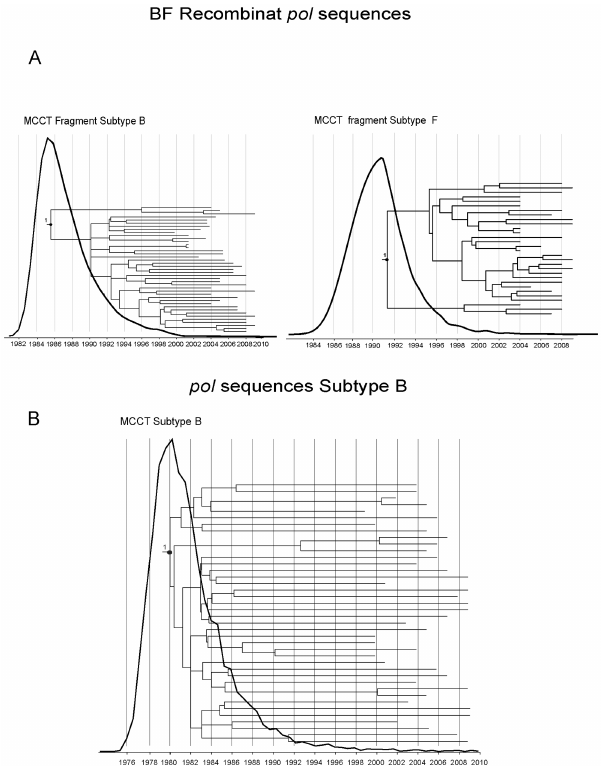
Fig 4. Bayesiananalysis for BF recombinant sequences and pure B sequences from MSM population. Time-calibrated maximum clade credibility trees (MCCT) of HIV-1 BF and B clades identified in the pol ML analyses.(A) For BF recombinant sequenceswe obtained two MCCT corresponding to the analysisof pure subtype B and F fragmentsindependently of each other. (B) MCCT obtainedby analyzingthe subtype B pure sequences. The posterior probabilities are indicatedat key nodes ( (cid:21) 0.90). In each tree, the node indicating the most recent common ancestor of the MSM Argentinian B and F sequencesfragments is indicatedwith a black